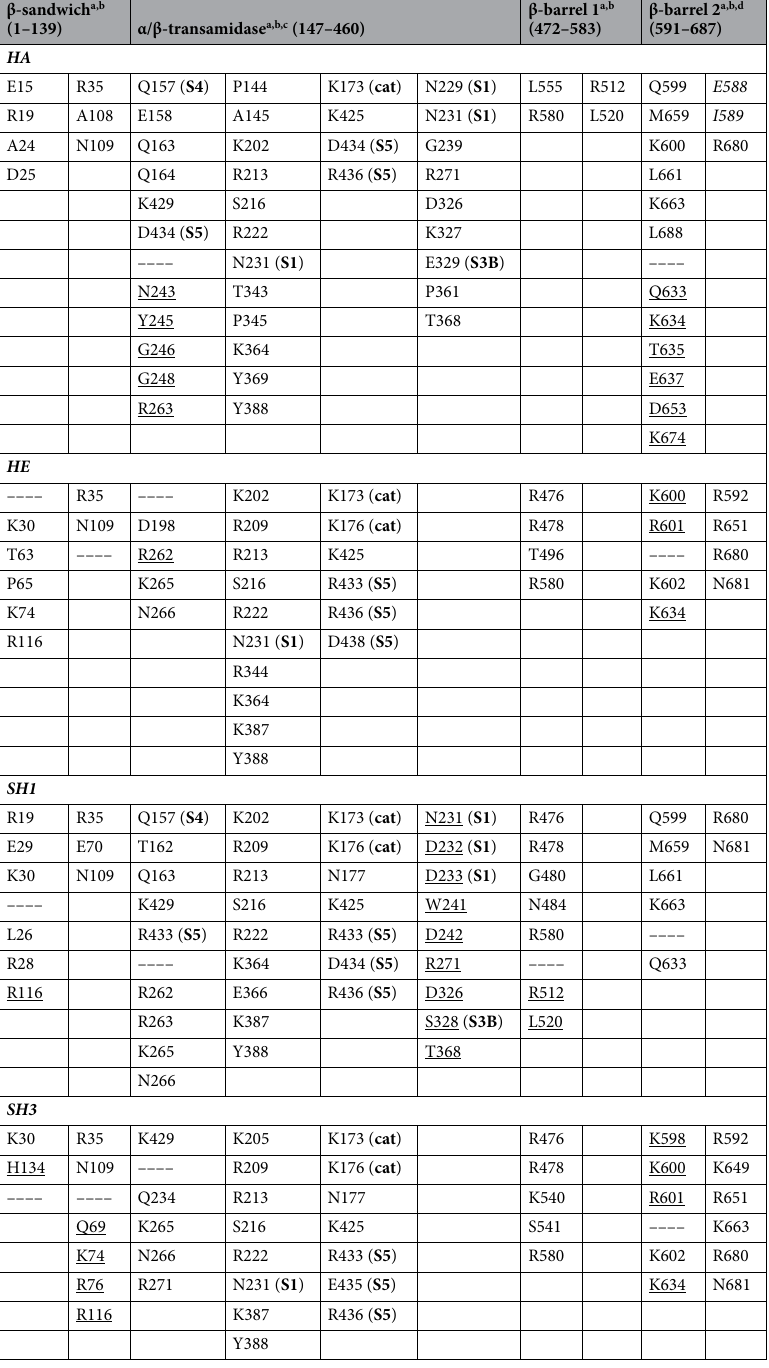
Table 2. Predicted recognition sites for GAG hexasaccharides on rhTG2 closed conformation. a Different recognition sites are shown in different columns or in the same column separated by dashed lines. b Underlined residues correspond to low populated GAG recognition sites. c It includes catalytic core ( cat ) (triad